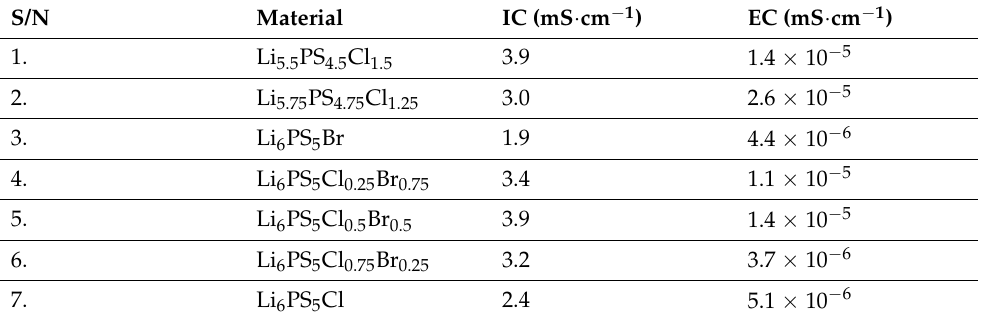
Table 2. Compendium of the ionic and electronic conductivities of lithium-argyrodites primed by synthesis method